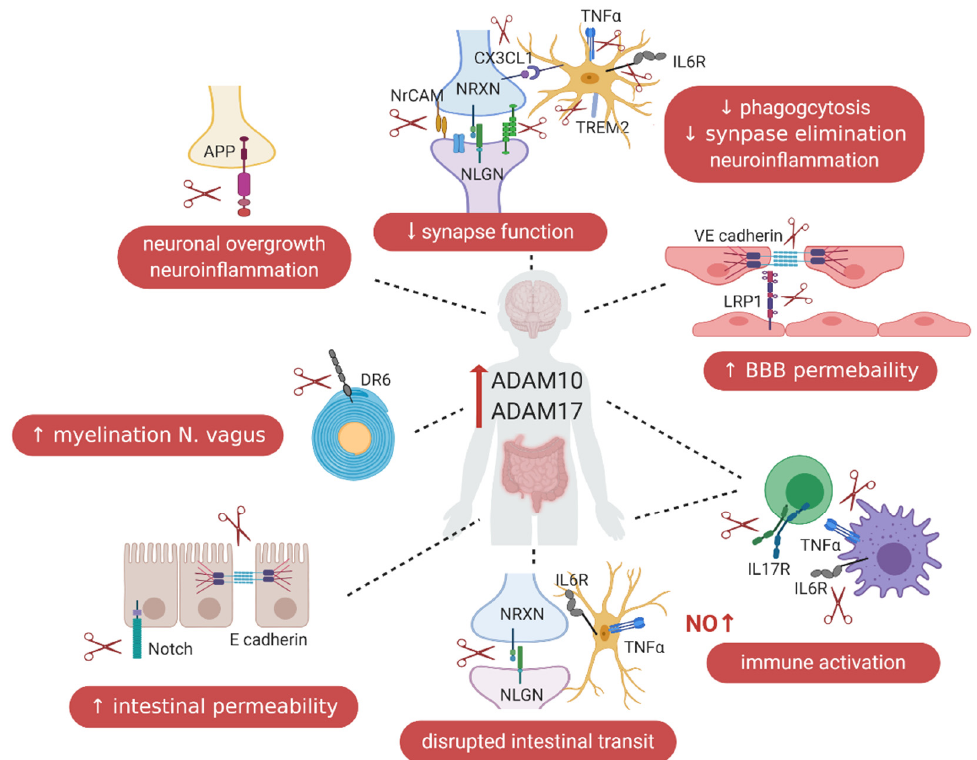
Figure 3. Overview of the proposed role of ADAM10 and ADAM17 in ASD pathology, with a focus on the gut–immune–brain axis. In the intestines, the increased activity or levels of ADAM10 and ADAM17 will lead to an increased intestinal permeability by cleaving more E-cadherin and Notch, increased intestinal inflammation by cleaving more IL-6R and TNF- α , disrupted intestinal transit by cleaving more NLGN3 and increased myelination of nervus vagus by cleaving more DR6 in the Enteric Nervous System; these contribute to the intestinal dysfunctions. In the brain, the elevated activity of ADAM10 and ADAM17 will result in increased neuronal growth, synaptic density, dendritic spines densities and larger brain volume by cleaving more synaptic molecules, such as NLGN, NRXN, NrCAM and APP. Furthermore, it will result in decreased synaptic elimination and microglial phagocytosis by cleaving more CX3CL1 and TREM2; increased neuroinflammation by cleaving more IL-6R, TNF- α and TREM2 and increased BBB permeability by cleaving more VE-cadherin and LRP1. These processes will lead to altered brain development and functions. Additionally, increased ADAM10 and ADAM17 activity will lead to immune activation by cleaving more IL-17R, IL-6R and TNF- α . All of these can participate ASD development and be involved in ASD pathogenesis.